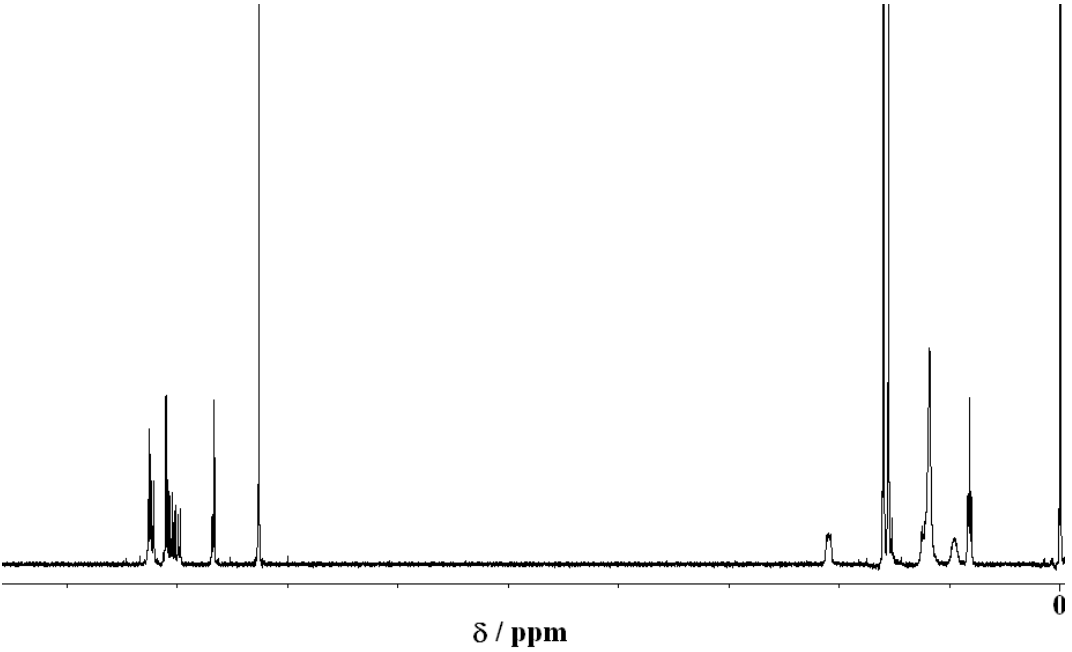
Figure S3. 1 H-NMR spectrum of 9,9 ′ -dioctyl-2,7-bis (7- tert -butyl-1-pyrenyl)-9H-fluorene ( 2-PyF , 400 MHz, CDCl 3